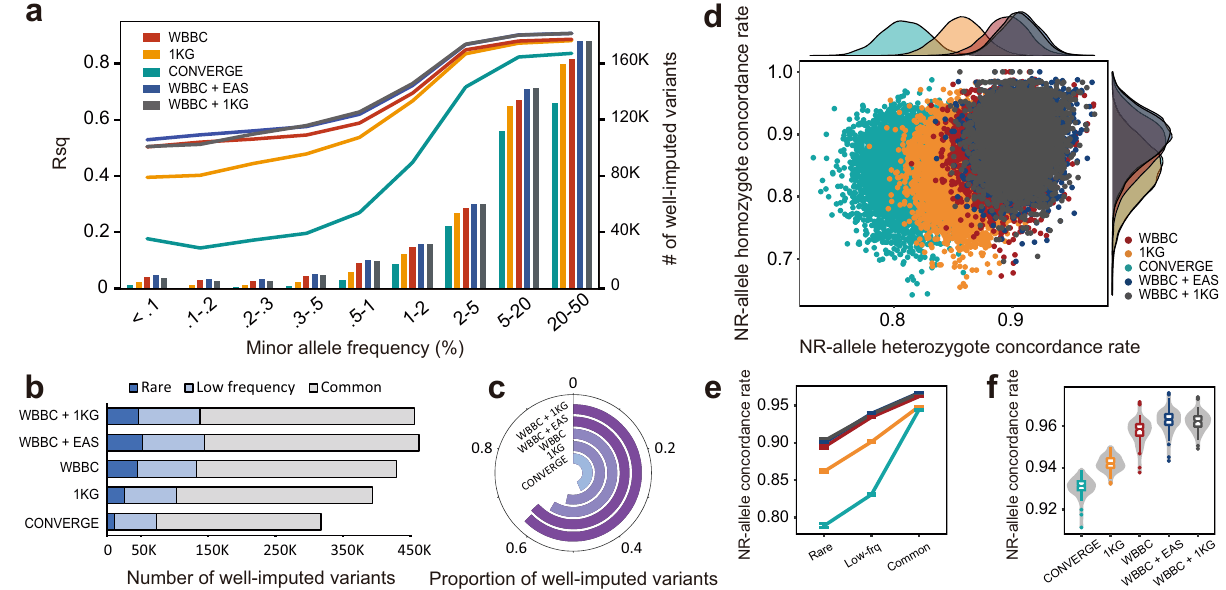
Fig. 3 Imputation performance of fi ve reference panels in the Han Chinese. a The average R -square ( R sq) and number of well-imputed ( R sq ≥ 0.8) variants in shared sites of fi ve reference panels (729,958 SNPs). All shared variants were grouped into nine MAF bins. b , c The cumulative number and proportion of well-imputed variants in shared sites of fi ve panels, there were 729,958 shared SNPs in total. d Non-reference allele (NR-allele) concordance rate distribution (imputed variants vs. array variants). Each dot represents an individual. The plots on the top and right are the corresponding density distributions. e , f The NR-allele genotype concordance rate for rare, low-frequency, and common variants and overall variants (imputed variants vs. WGS variants). A total of 184 unrelated samples with both sequencing and genotyping data were used for the evaluation. The concordance rates for each variants group with mean value ± SEM, and quartile for each panel were plotted. The 1KG means 1000G Phase 3 and EAS means East Asian group in 1000G Phase 3. All imputations were conducted on chromosome 2. Source data are provided as a Source Data fi